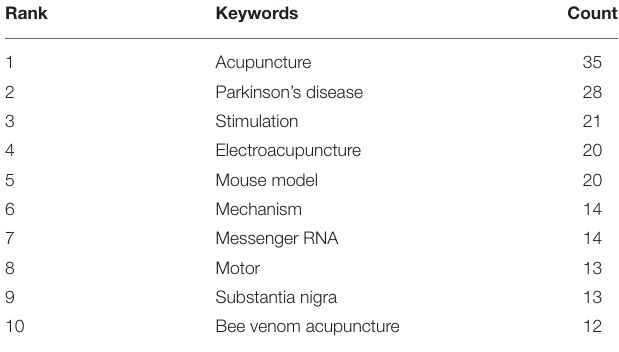
TABLE 5 | Top 10 keywords in the treatment of acupuncture for PD.